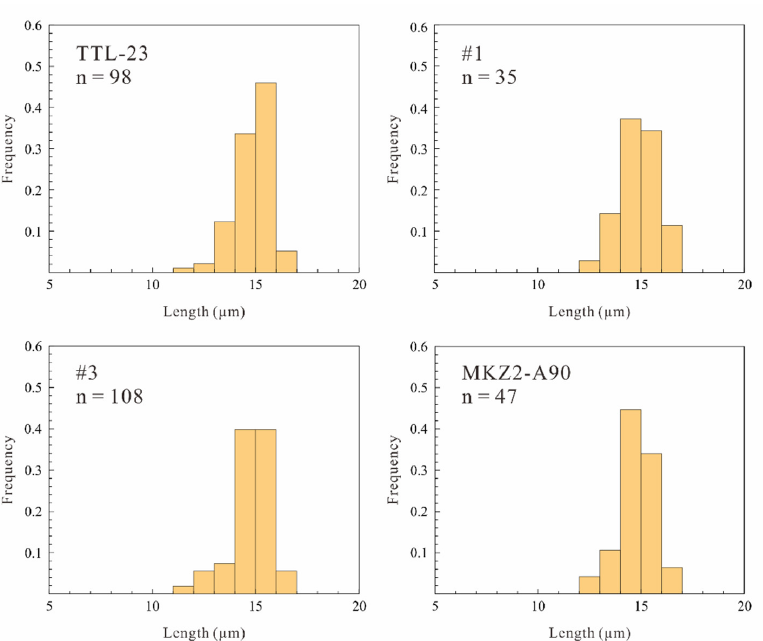
Figure 4. Confined track length distributions.